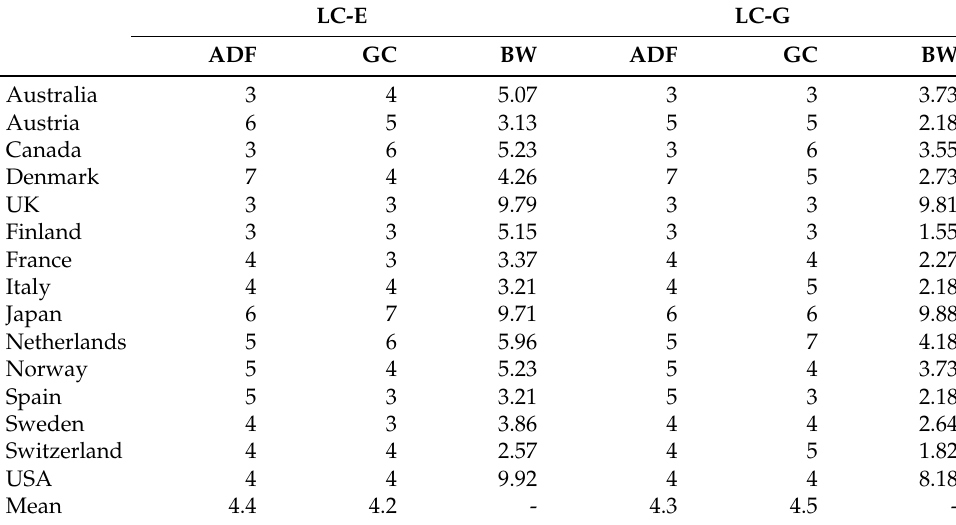
Table 1. Unit root/Granger causality tests and